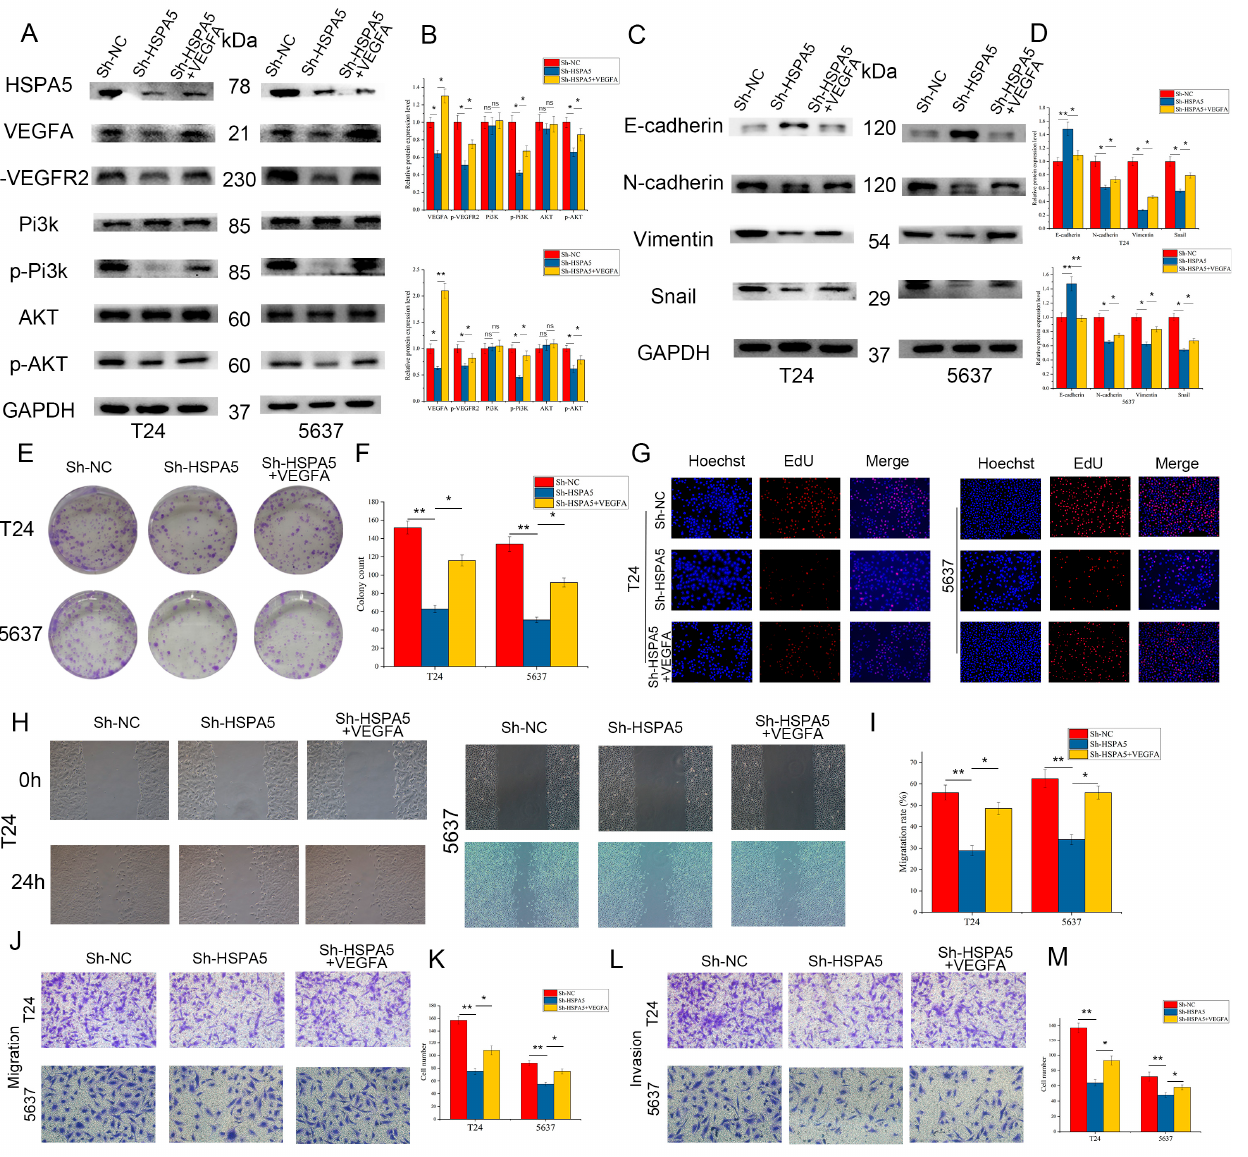
Figure 7. VEGFA reversed the inhibitory effect of HSPA5 knockdown. ( A , B ) VEGFA overexpression activated the PI3K/AKT signaling pathway after it was inhibited by HSPA5 downregulation. ( C , D ) The expression of EMT-related proteins was measured. ( E , F ) Colony formation assay and ( G ) EdU assay (200 × ) demonstrating that VEGFA promoted BCa cell growth. ( H – K ) The migration abilities of the cells in different groups were measured by wound-healing assay (100 × ) and migration assay (200 × ). ( L , M ) Cell invasion capability increased after transfection with VEGFA (200 × ). All data are presented as the mean ± SD. * p < 0.05, ** p < 0.01.